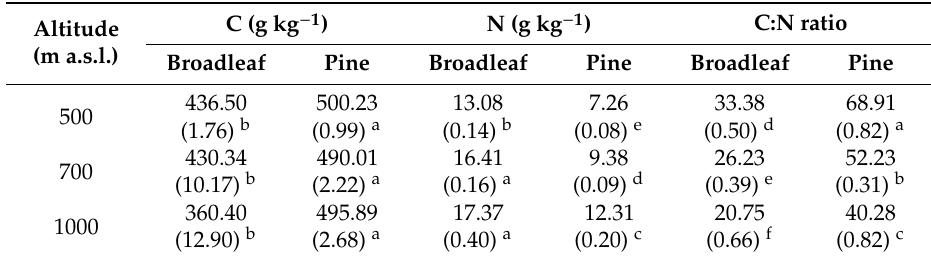
Table 2. Carbon (C) and nitrogen (N) contents and C:N ratio of the decaying leaves and needles collected from the Oi horizons of the broadleaf and pine forests, respectively, at 500, 700 and 1000 m a.s.l., Mount Cucco massif (Central Apennines, Italy). Di ff erent letters indicate significant di ff erences according to